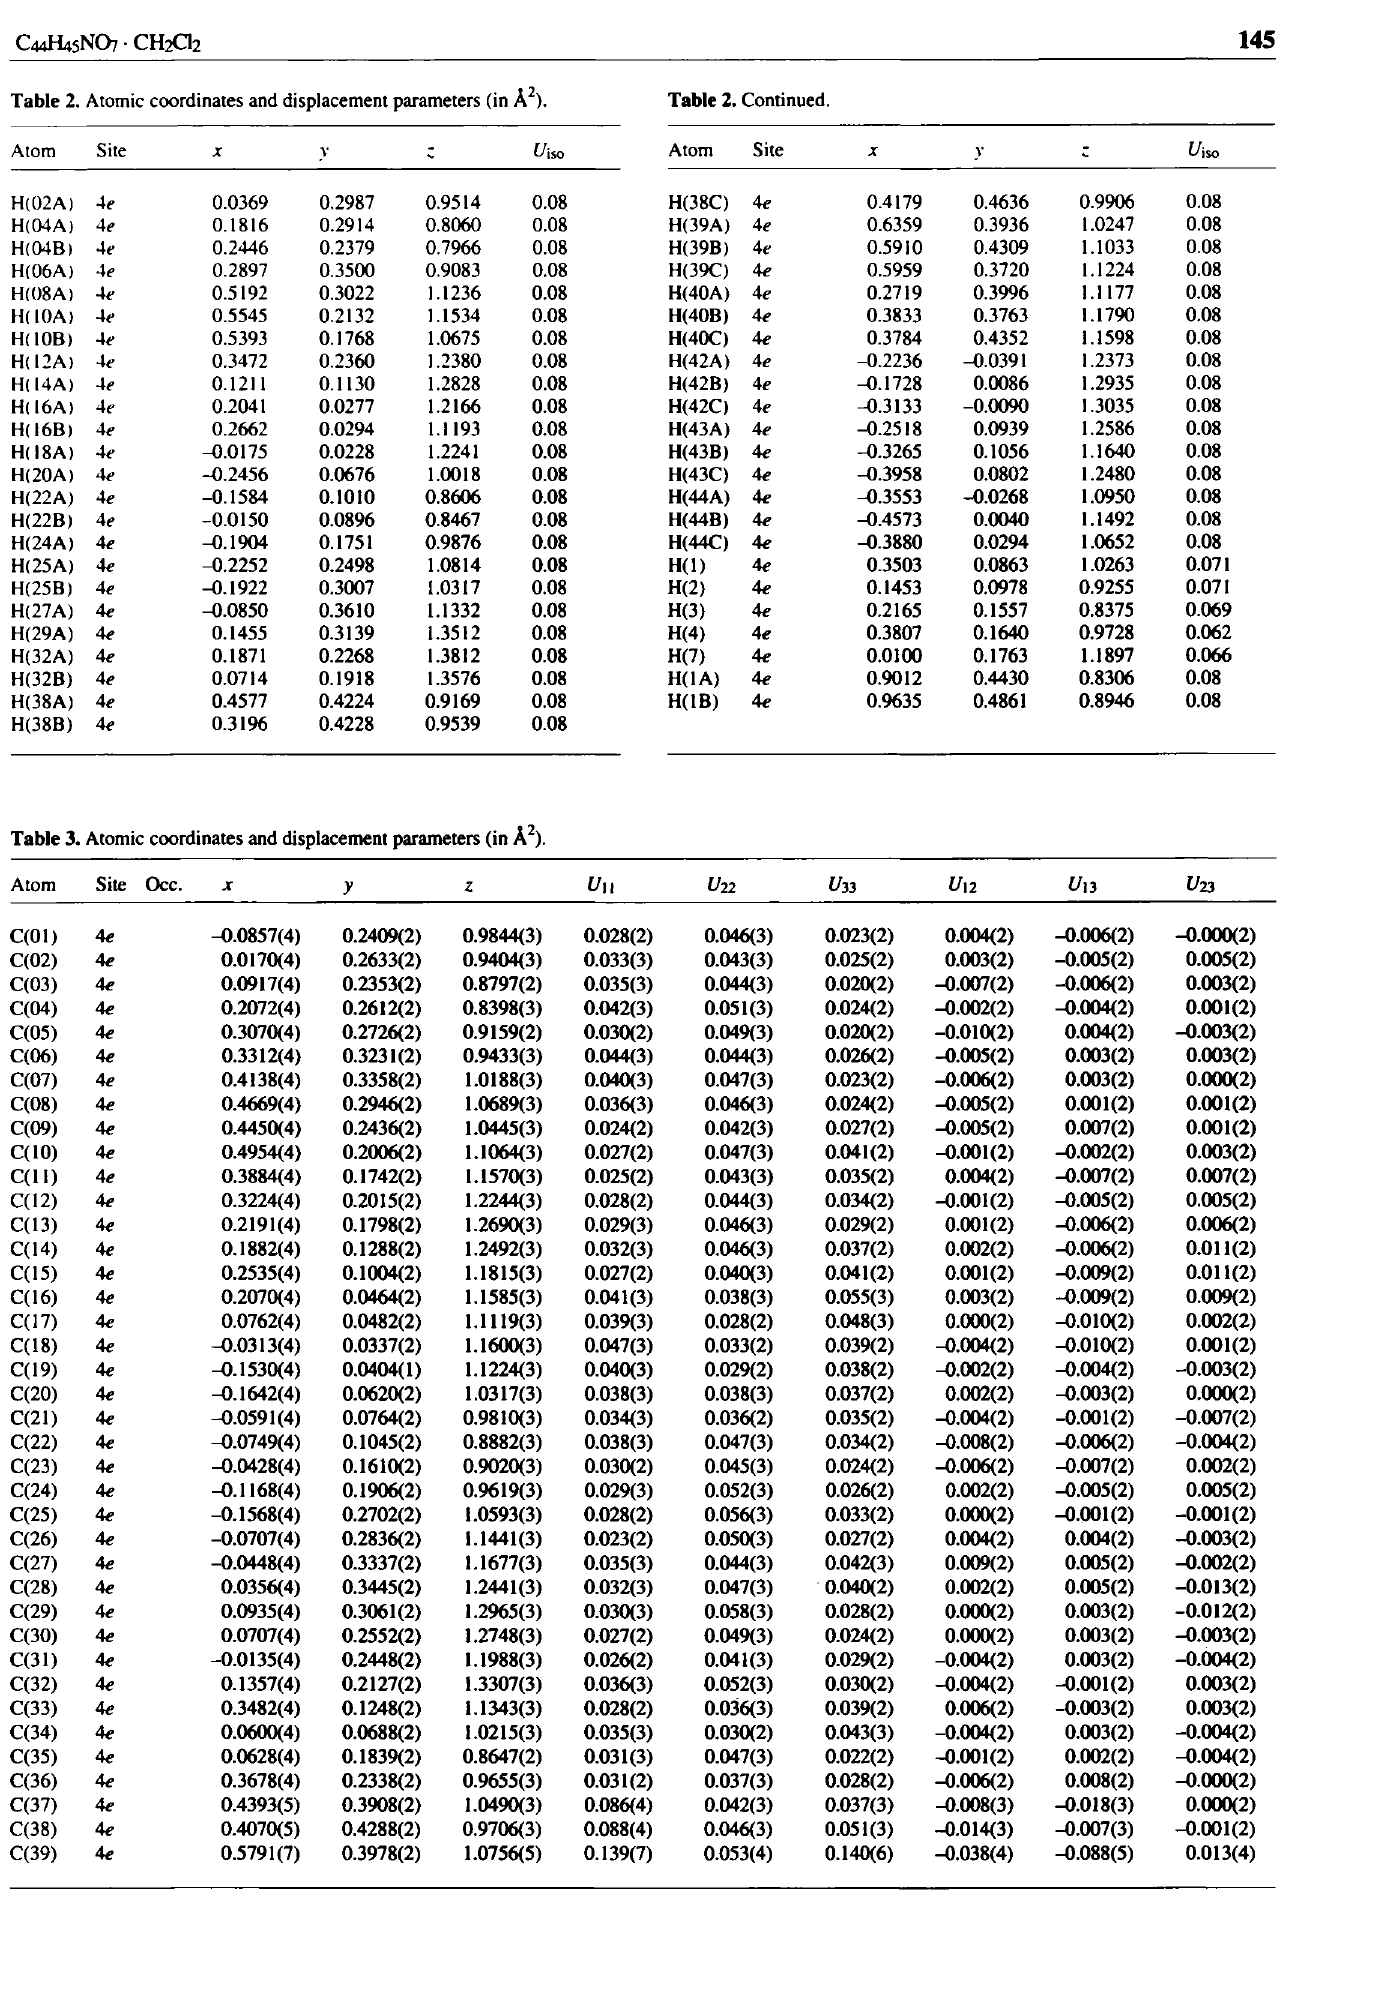
Table 3. Atomic coordinates and displacement parameters (in Â 2